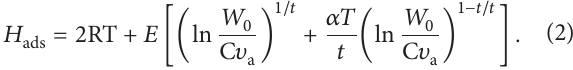
Figure 8: Heat of adsorption (𝐻 pair against different surface loading ( 𝑊/𝑊 0 ) at 298 K. ◼ : CS0; ◻ : CS3; e : CS6; and I :